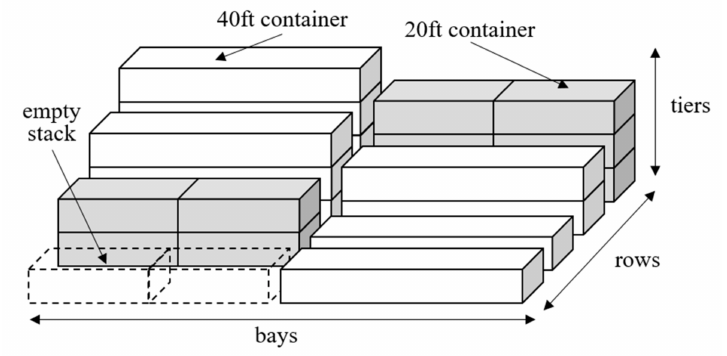
Figure 2. Structure of a storage block (adapted from [12]).